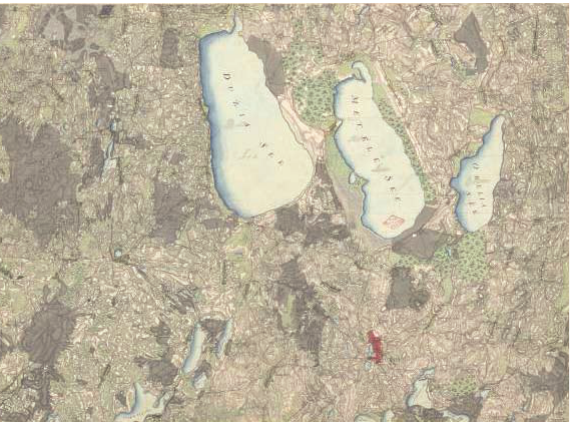
Fig. 14. The new province of East Prussia in a military